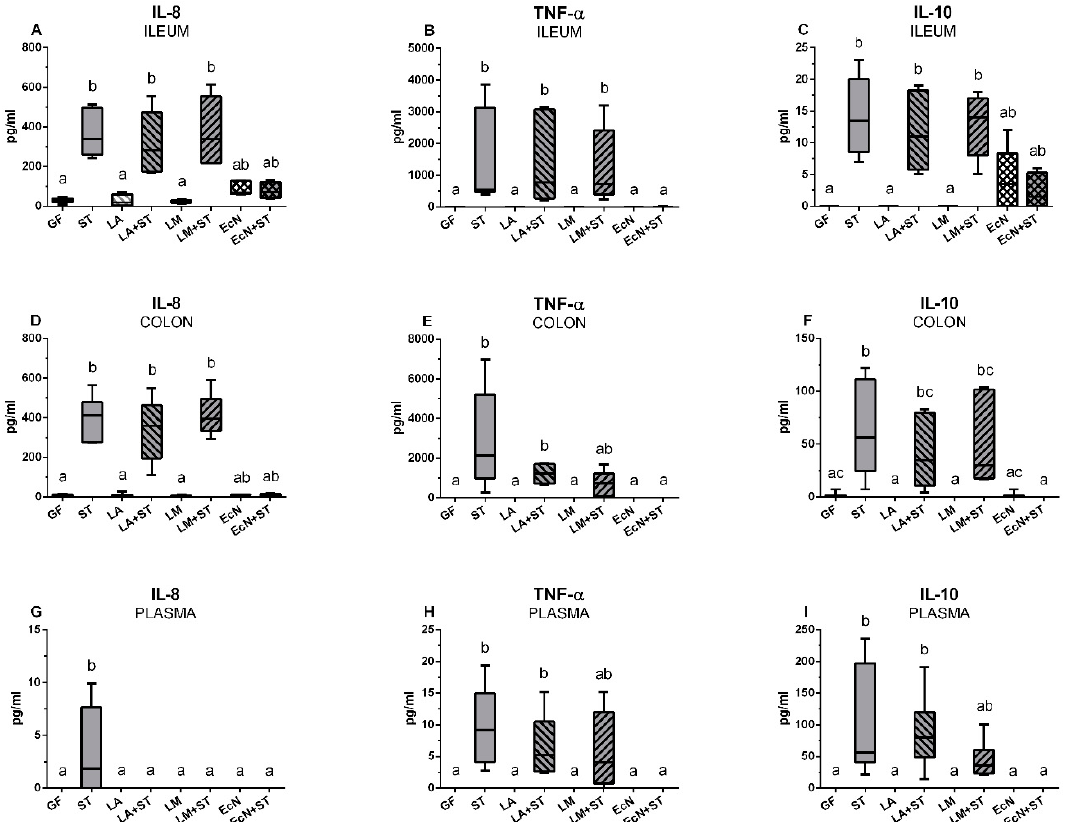
Figure 6. Local and systemic levels of IL-8, TNF- α , and IL-10 in the gnotobiotic piglets. The levels of IL-8 ( A , D , G ), TNF- α ( B , E , H ), and IL-10 ( C , F , I )) in the ileum (A,B,C), colon (D,E,F), and plasma (G,H,I) in the germ-free piglets (GF) and the piglets colonized/infected with L. amylovorus (LA and LA+ST), L. mucosae (LM and LM+ST), E. coli Nissle 1917 (EcN and EcN+ST), and S . Typhimurium (ST, LA+ST, LM+ST, and EcN+ST) are depicted. Kruskal–Wallis test with Dunn’s multiple comparison post-hoc test was used to compare differences among the groups. The cytokine levels were measured in six piglets per group. The values are presented as median and range. Statistical differences P < 0.05 are denoted with different letters above the columns and the same letter shown above the column indicates no statistically significant differences.